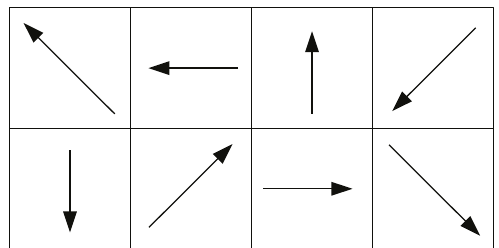
Figure 1: Direction of magnetic moment of ferromagnetic material in original state.